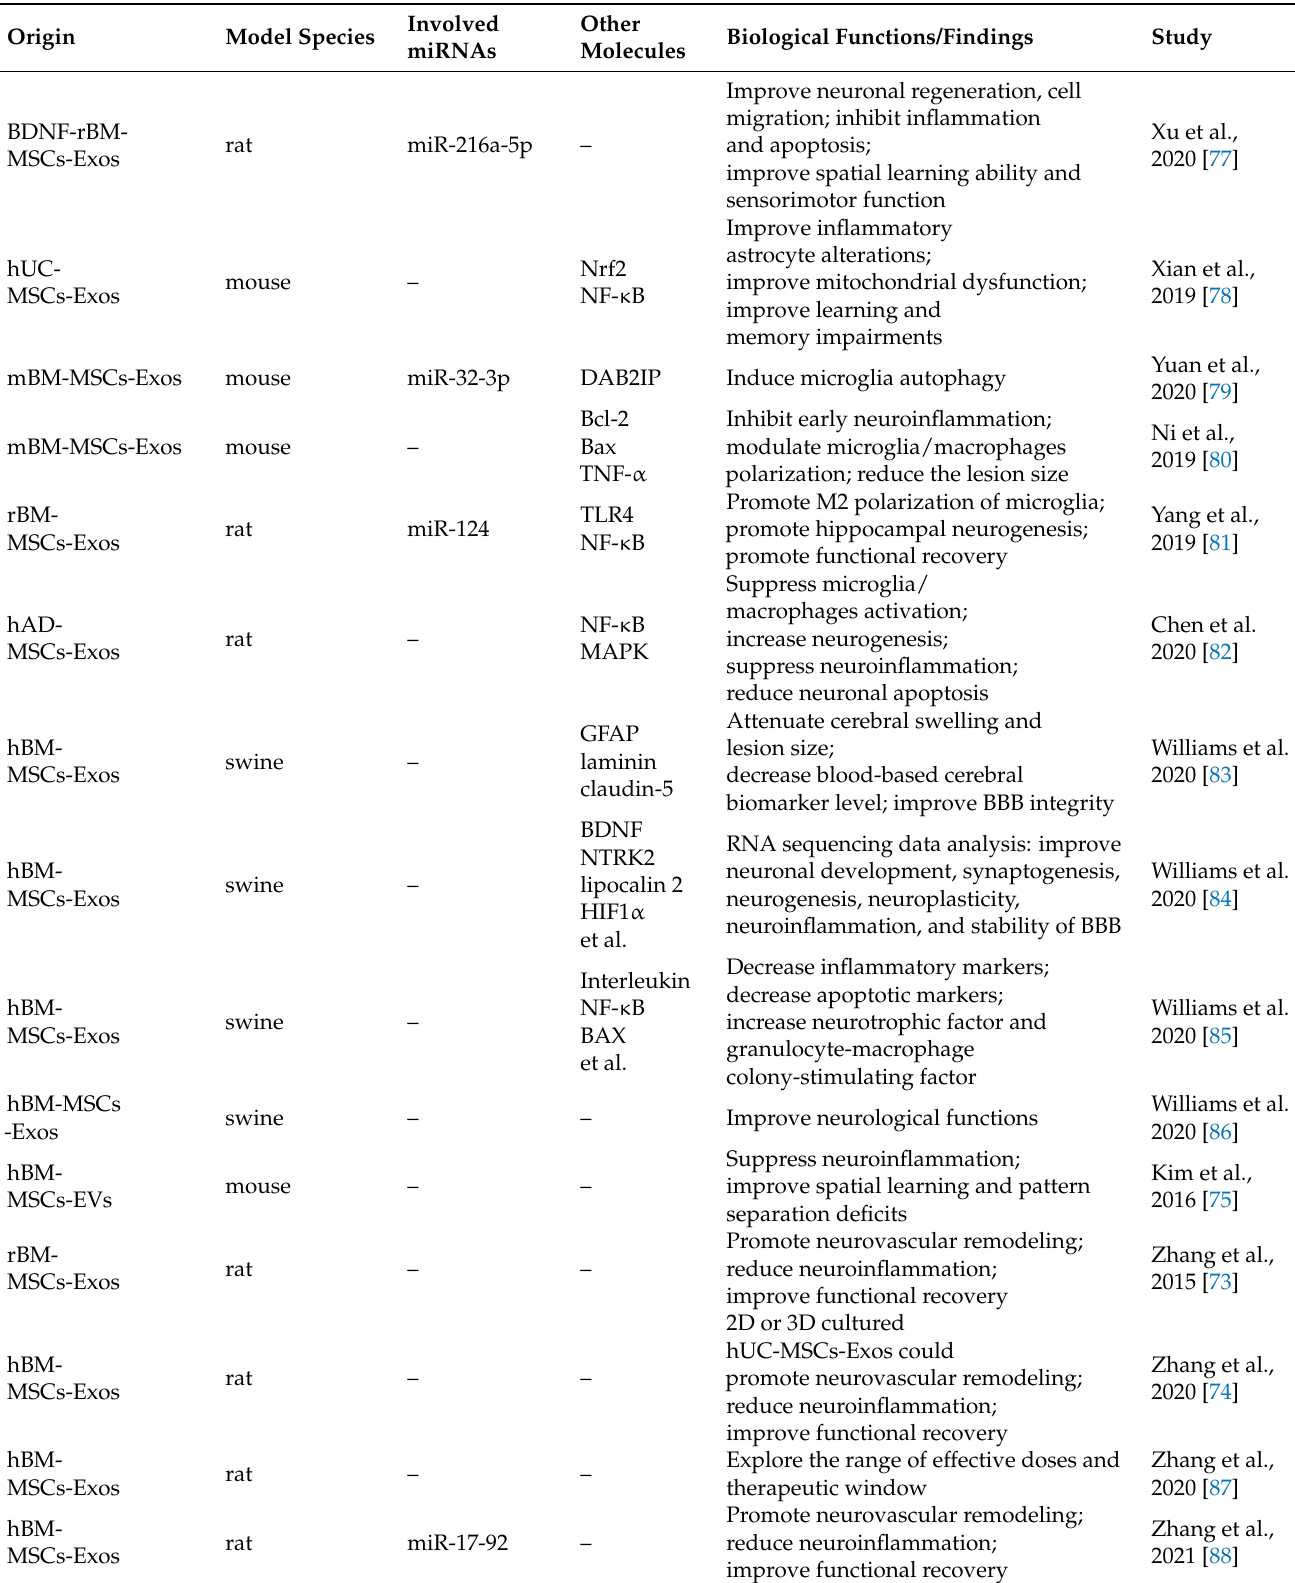
Table 4. Mesenchymal stem cell derived Exos/EVs and MSCs-Exos/EVs-miRNAs studies in